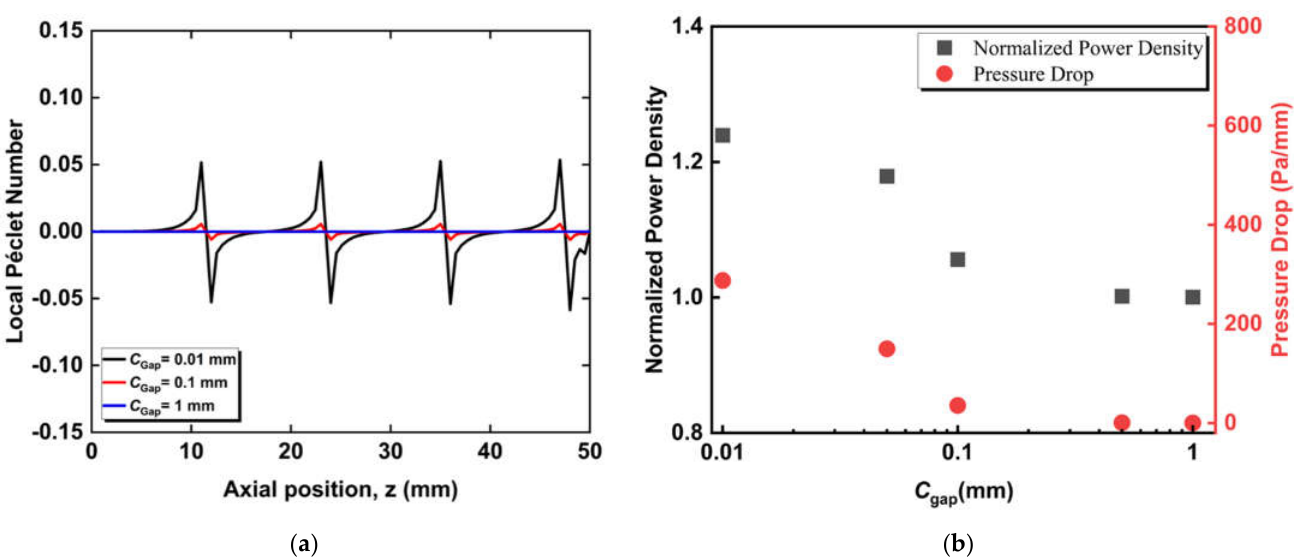
Figure 6. The influence of cone-insert of different gaps on ( a ) local Péclet number variation in the anode-fuel channel interface along the axial direction, ( b ) the output power density and the gas-phase pressure drop of the micro-tubular SOFC.